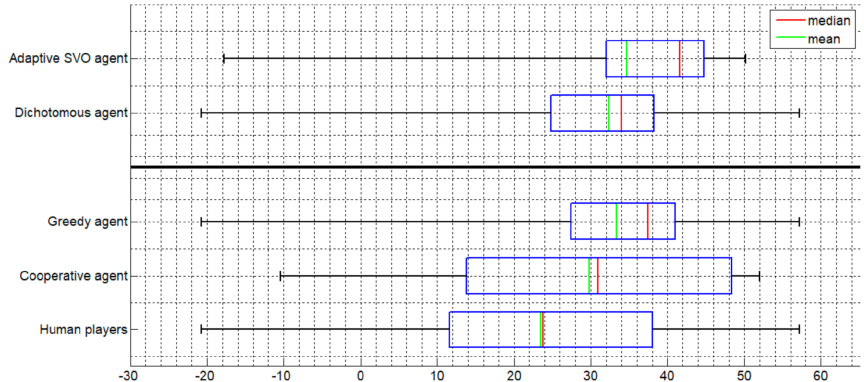
Figure 2. Agent plays as a type 1 (blue)